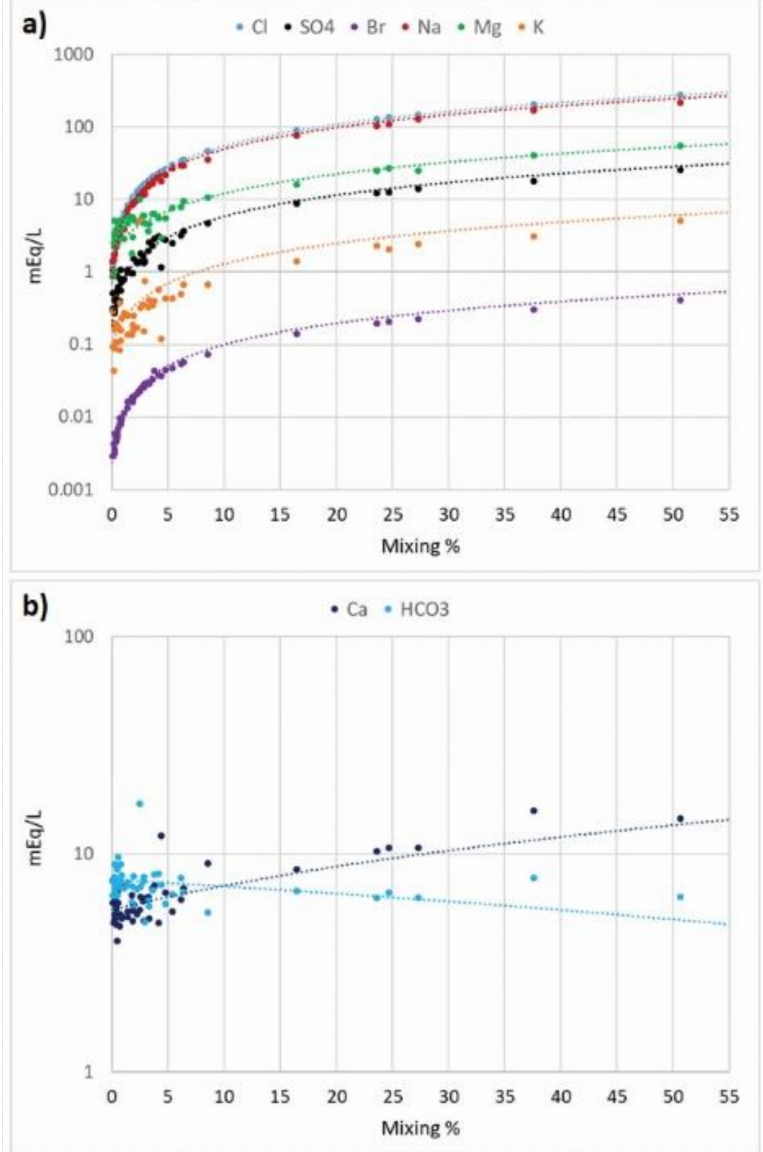
Figure 4. ( a ) Concentration trends of the parameters more influenced by seawater intrusion (SW/FW ≥ 30), ( b ) parameters less influenced by seawater intrusion (SW/FW ≤ 4). Dotted lines represent the simulated mixing of the two end-members, while points represent the concentrations observed at the sampling points (mixing percentage calculated by Equation